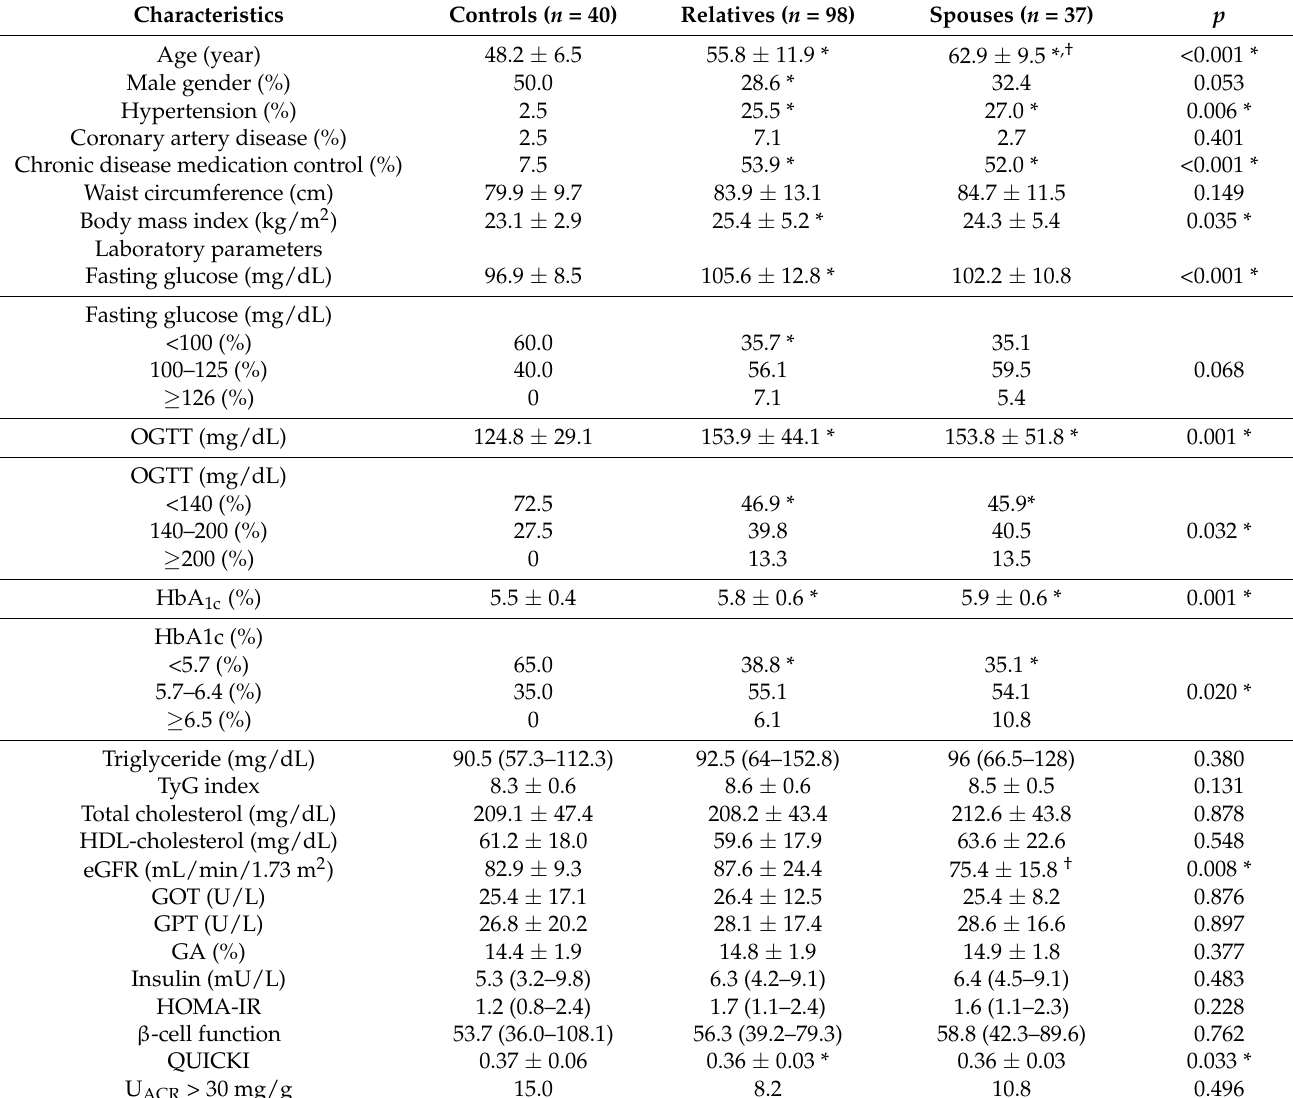
Table 1. Comparison of clinical characteristics between controls, relatives and spouses of DM patients.